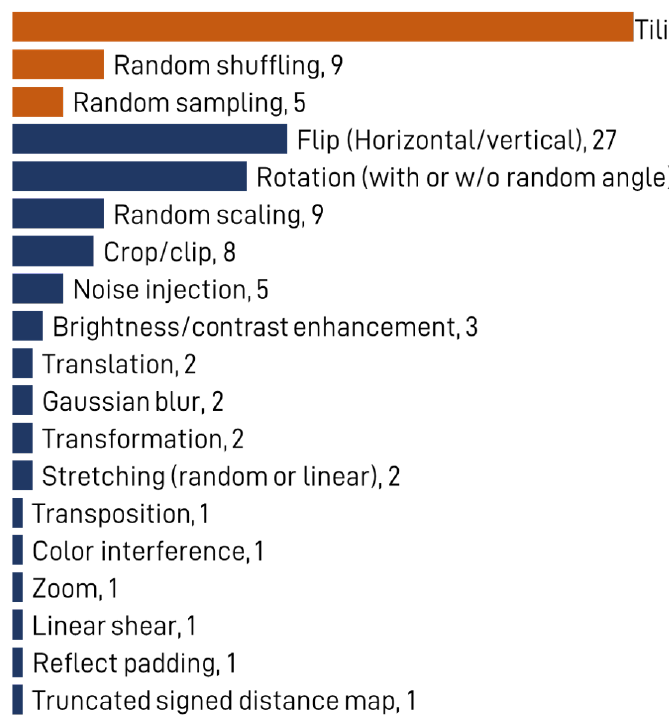
Figure 3. Distribution of image preparation and augmentation methods